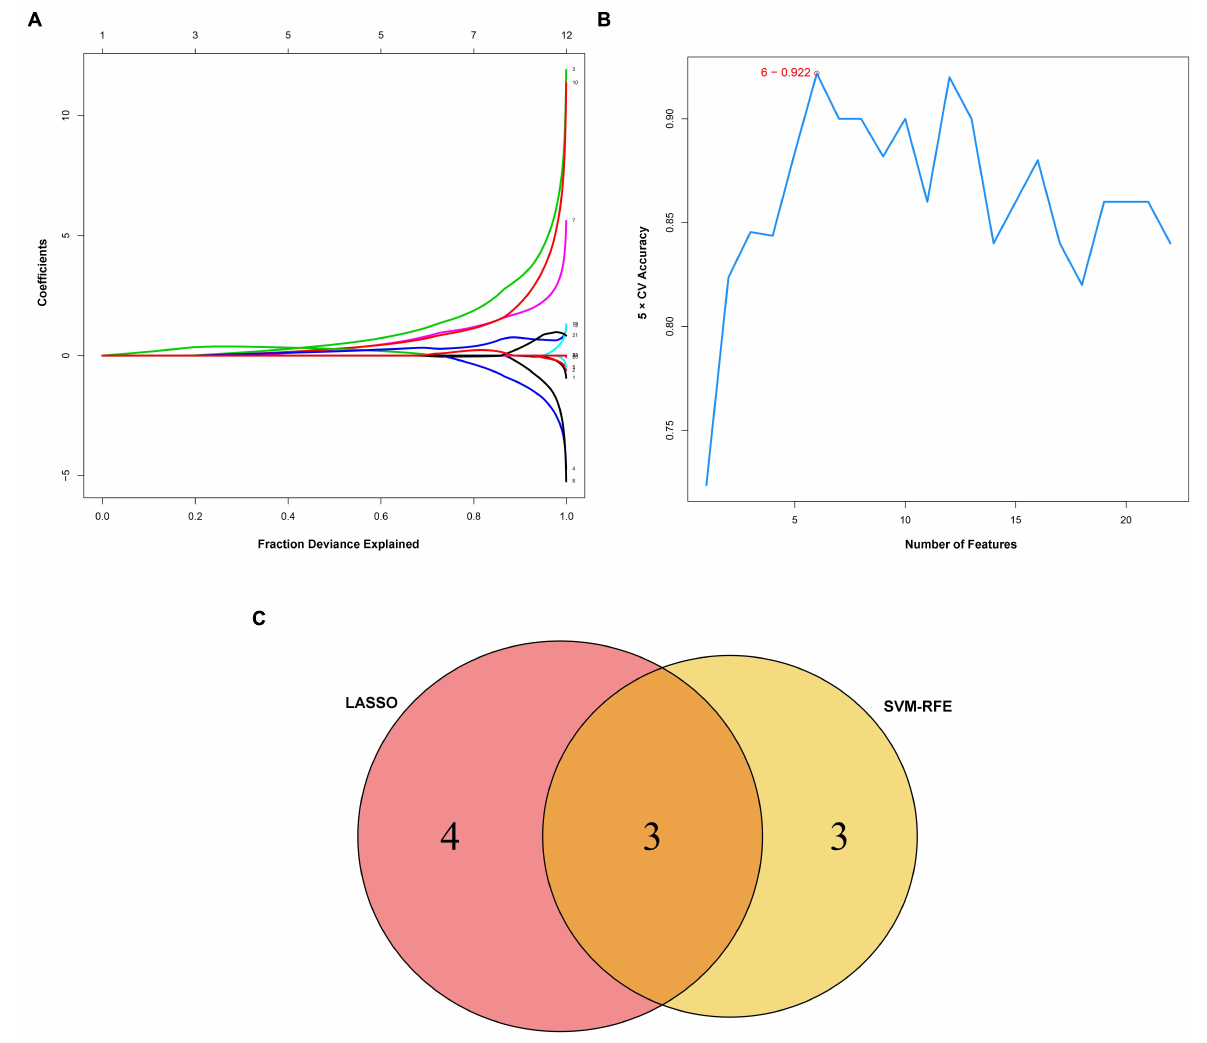
FIGURE 5 | Identification and verification of diagnostic markers. (A) Diagnostic markers identified using the least absolute shrinkage and selection operator (LASSO) logistic regression algorithm. Different colors represent different genes. (B) Support vector machine-recursive feature elimination (SVM-RFE) algorithm to screen diagnostic markers. (C) Venn diagram showing the intersection among diagnostic markers between the two